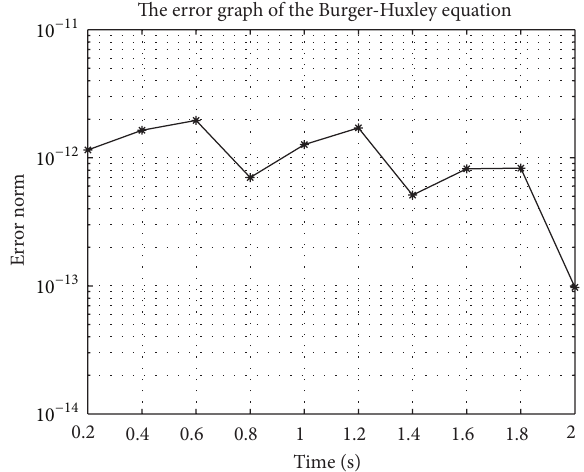
Figure 10: Burgers-Huxley equation error graph.